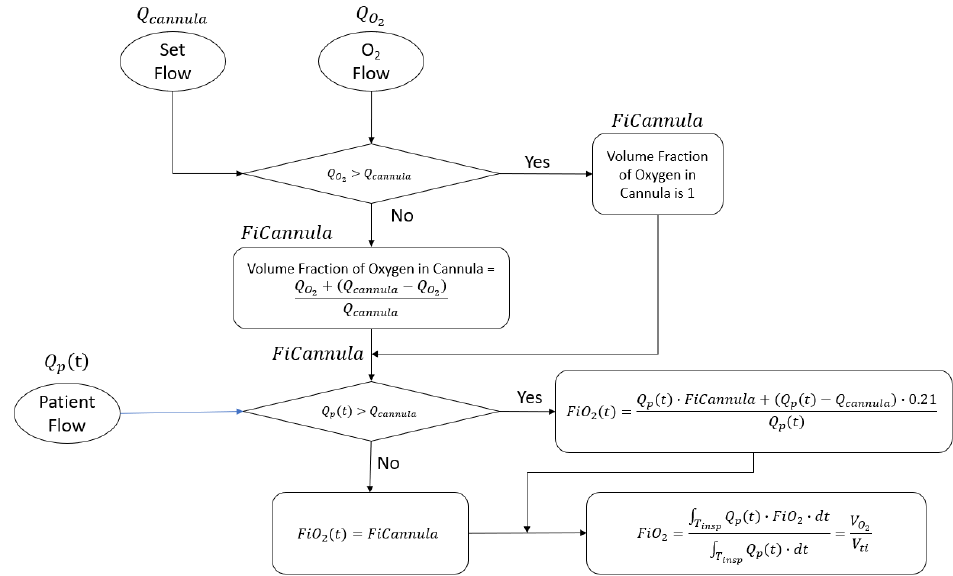
Figure 11. In this figure, the two clinical inputs for HFNT are the set flow and the bleed-in O 2 flow. The model applies a time-varying patient flow waveform, Q p ( t ) , and estimates tracheal F i O 2 based on the mixing of the treatment flow and the entrained room air with the additional dilution occurring when the flow setting is greater than the bleed-in O 2 flow.